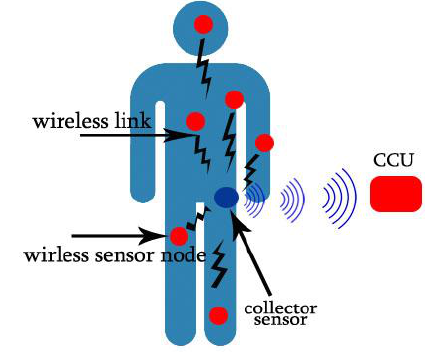
Figure 5: Schematic of an example WBAN on the human